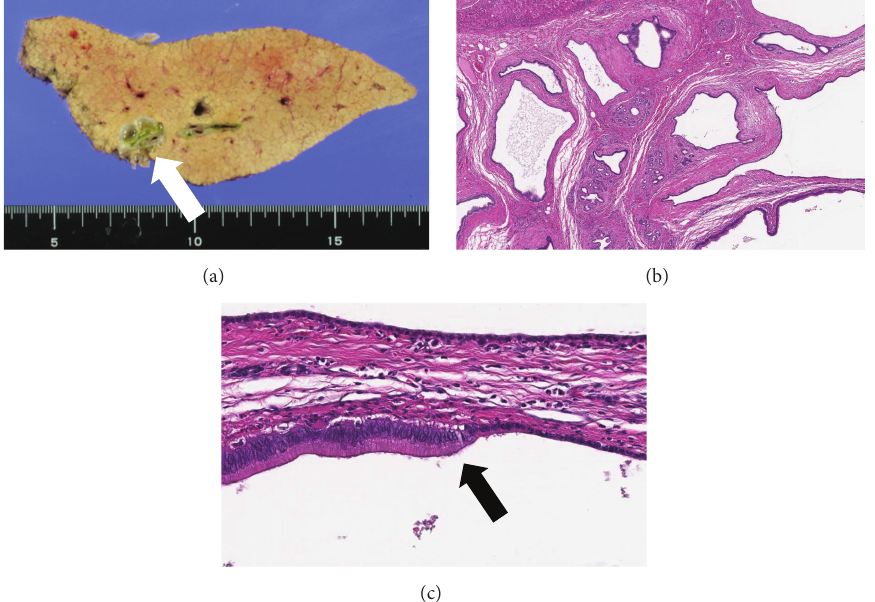
Figure 4: (a) Macroscopic findings of the resected specimens showed multiple cystic lesions surrounding the intrahepatic bile duct (arrow). (b) Multiple cystic dilatations of the extramural peribiliary glands with mucus production were observed (HE stain, × 40). (c) Front formation on the BilIN was observed in the intrahepatic bile duct (HE stain, ×